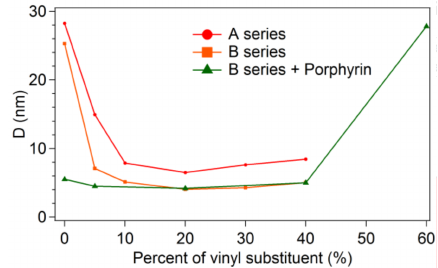
Figure 5. Average sizes obtained from the data fitting of the SANS curves versus the vinyl percentage.